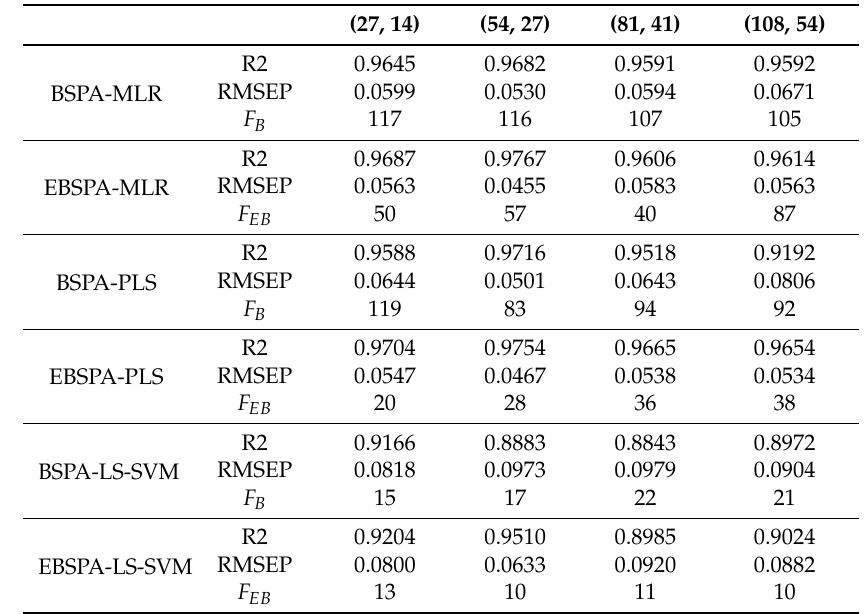
Table 4. Comparison of EBSPA and